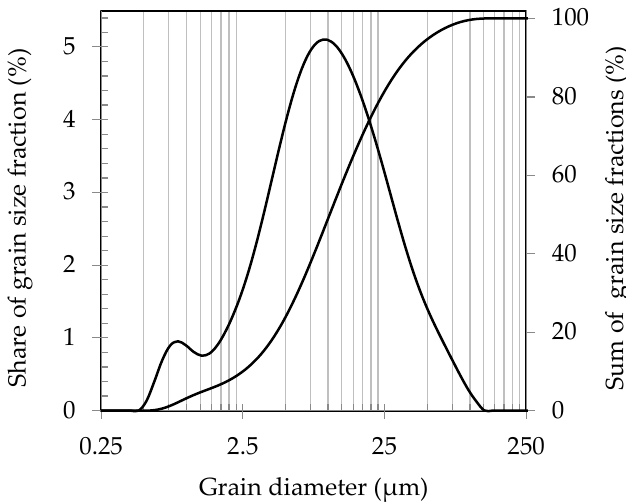
Figure 1. Grain size distribution curve of the tested hydromixture. The grain size ranged from 0.5 µ m to 163.5 µ m, with an average grain size of 45.5 µ m. The dust fraction with a mean grain diameter ranging from 2 µ m to 50 µ m had the largest share in the sample (about 65%). The sand fraction, characterizing particles with an average grain diameter larger than 50 µ m, represented almost one third of all particles. The clay particles constituted only 3.38% of all the particles contained in the hydromixture. Chemically, the test hydromixture consisted mainly of calcium oxide CaO (73.6%) and silicon oxide (SiO 2 —13%). The other chemical compounds in the hydromixture were: magnesium oxide (MgO—0.6%), iron oxide (Fe 2 O 3 —0.3%), aluminum oxide (Al 2 O 3 —1.1%) and sulfur trioxide (SO 3 —0.3%). Substances that could not be identified accounted for approximately 11.1% of the